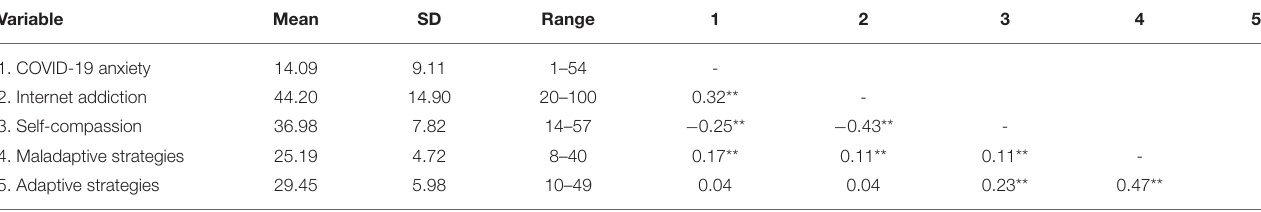
TABLE 2 | Descriptive statistics and the correlation matrix ( n = 1,008). Variable